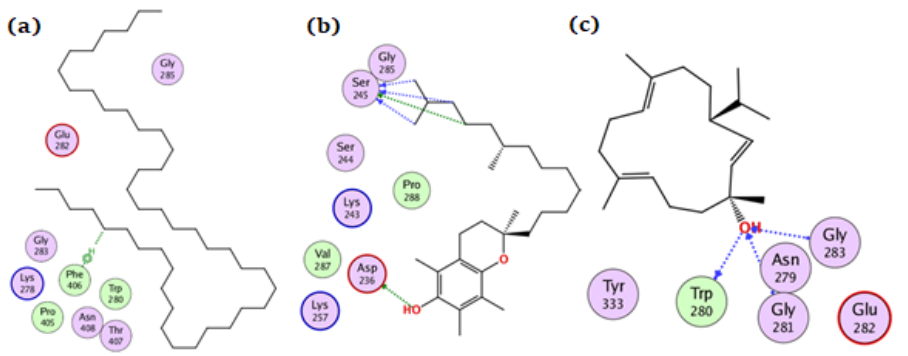
Figure 6. The docking of ( a ) tetratetracontane, ( b ) α -tocopherol, and ( c ) thunbergol on the active site of amylase enzyme (PDB code: 4gqq).